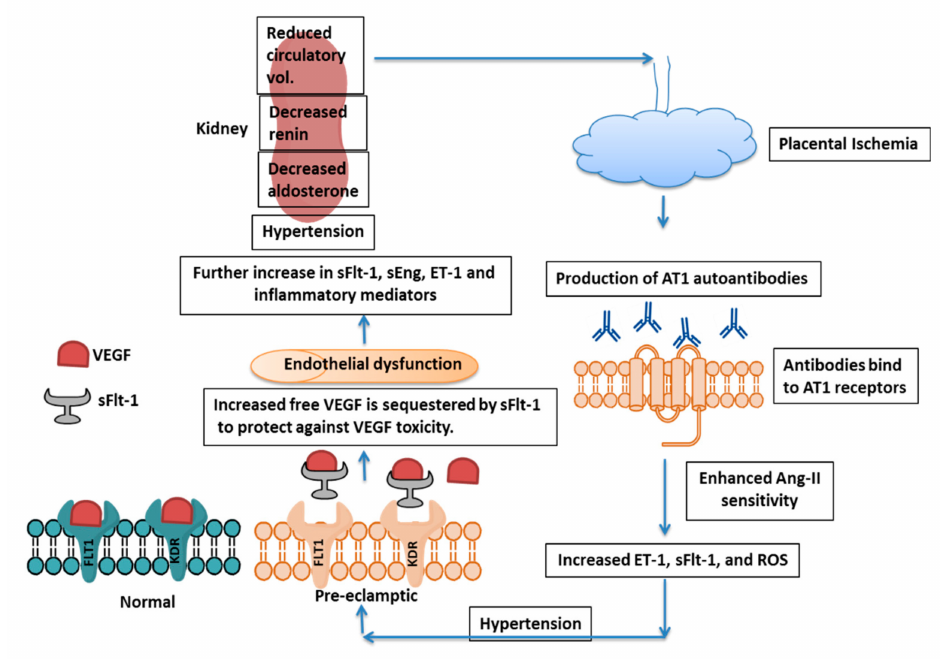
Figure 2. Mechanism of PE Pathogenesis. Placental ischemia induces AT1 autoantibody formation, which further increases Ang-II sensitivity, leading to enhanced ET-1, sFlt-1, and ROS production. sFlt-1 acts as a decoy receptor and blocks free VEGF to protect the fetus from toxicity by excess VEGF, although there is endothelial dysfunction and e ff ect on kidney. AT1 = Angiotensin-II type 1, Ang-II = angiotensin-II, ET-1 = Endothelin-1, sFlt-1 = soluble fms-like tyrosine kinase-1, ROS = Reactive Oxygen Species, VEGF = Vascular Endothelial Growth Factor, KDR = Kinase insert Domain Receptor and sEng = soluble